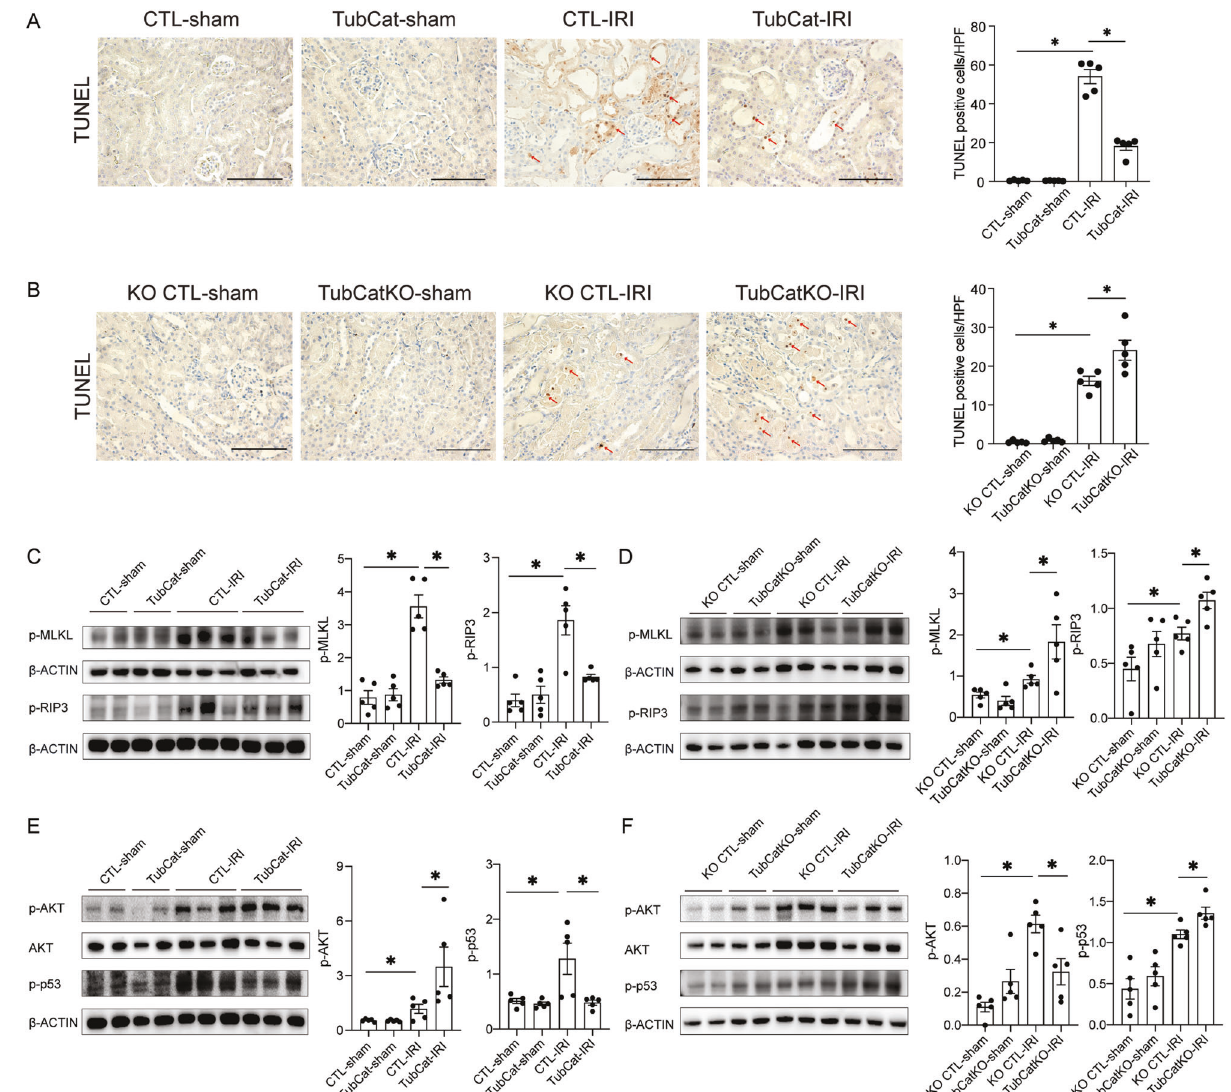
Fig. 3 β -catenin reduces kidney cell death in IRI-induced AKI via AKT/p53 signaling. A , B Apoptotic cell death: Representative TUNEL staining and quanti fi cation of apoptotic cells per HPF in kidney cortex from TubCat-IRI mice ( A ) and TubCatKO-IRI mice ( B ). Red arrows, apoptotic cells; Scale bar = 100 μ m. HPF high-power fi eld. * p < 0.05; n = 5 in each group. C , D Necroptotic cell death expressed as protein expression of phosphorylated necroptotic executive proteins, MLKL and RIP3 (p-MLKL and p-RIP3) by Western blots of kidney cortical lysates and quantitative analyses in TubCat-IRI mice ( C ) and TubCatKO-IRI mice ( D ). * p < 0.05; n = 5 in each group. E , F Representative Western blots of p-AKT and p-p53 and their quanti fi cation in TubCat-IRI mice ( E ) and in TubCatKO-IRI mice ( F ). * p < 0.05; n = 5 in each (Fig. 2E and Suppl Table S2). NGAL overexpression in the tubules were ameliorated in TubCat mice but exacerbated in TubCatKO mice (Fig. 2G). NGAL/ β -catenin co-staining showed that reduced NGAL overexpression was observed mainly in β -catenin-positive tubules (Fig. 2F).